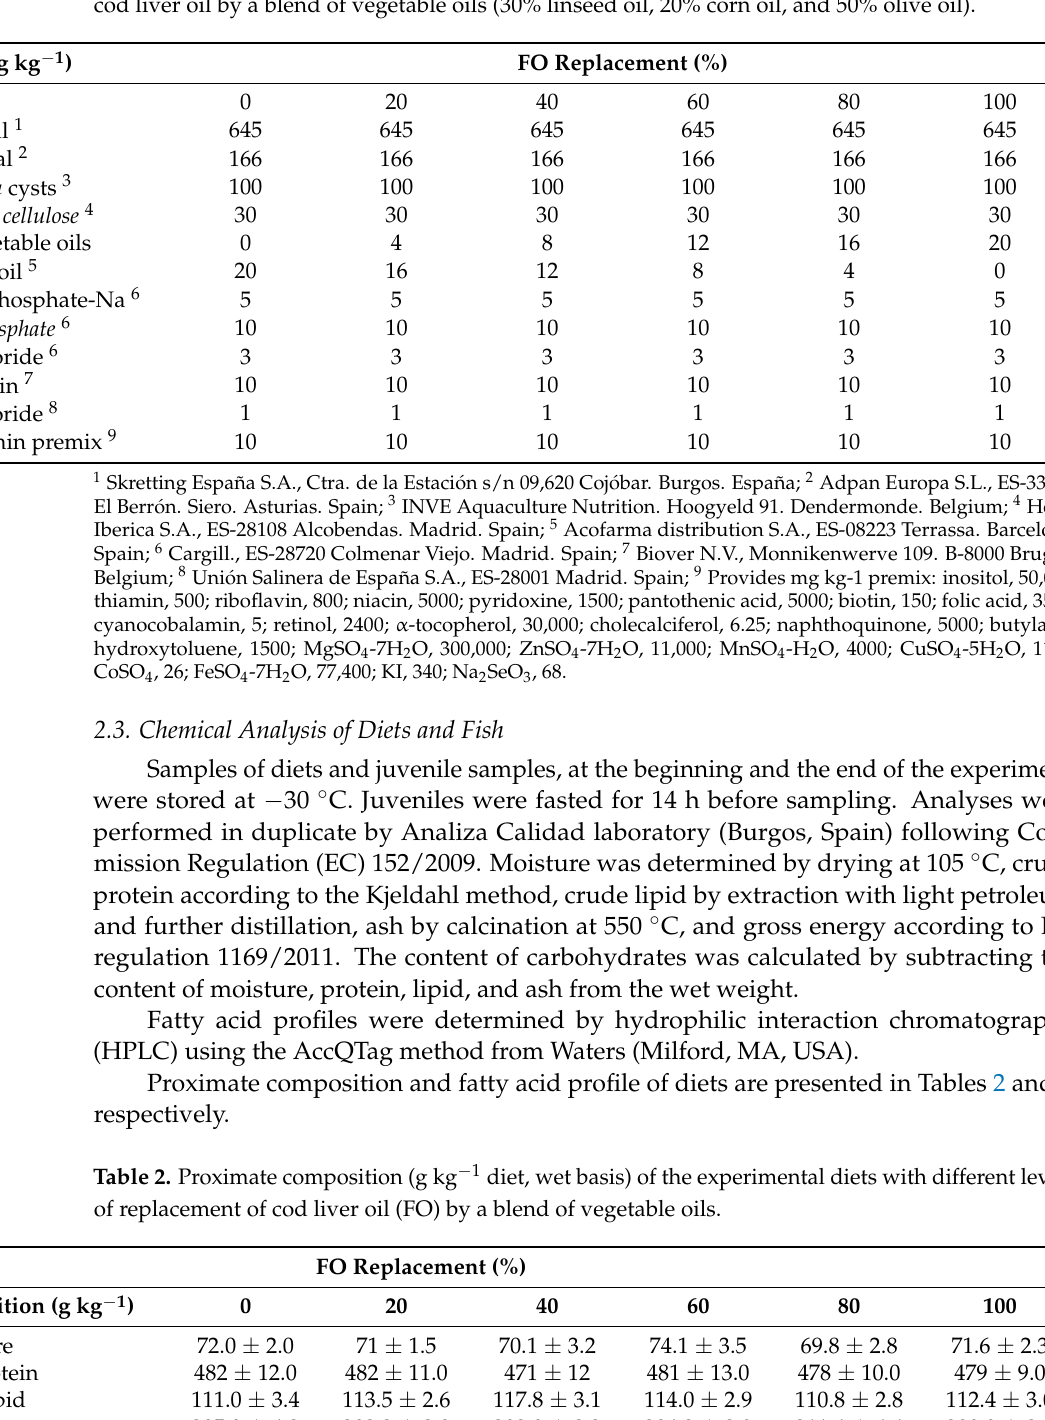
Table 1. Formulation of the experimental diets (g kg − 1 diet) with different levels of replacement of